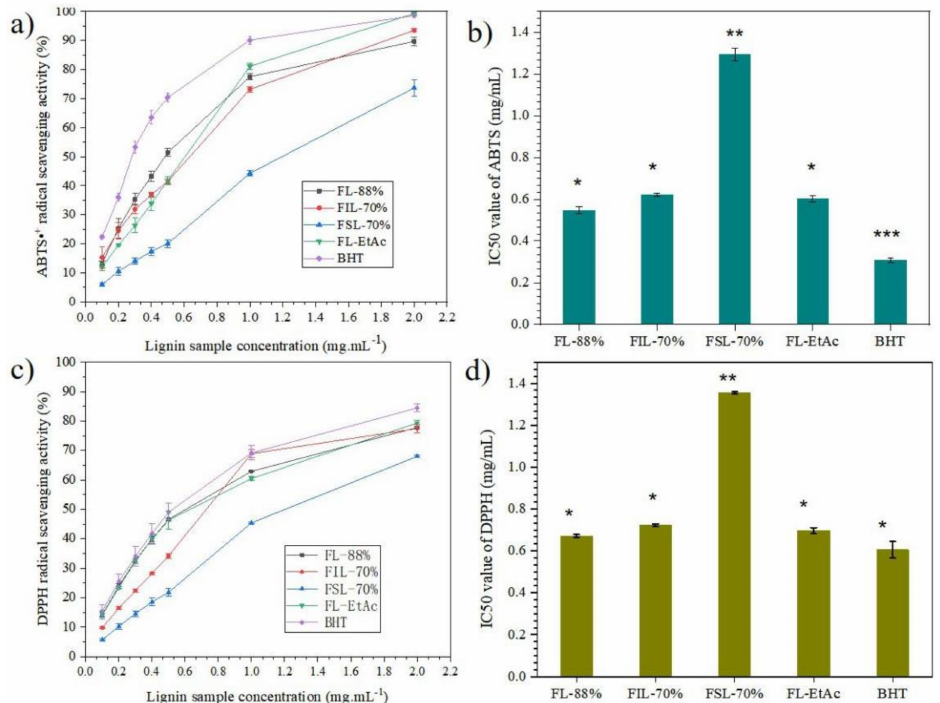
Figure 8. Antioxidant capacities of ABTS and DPPH radical scavenging activity for isolated lignin fractions. ( a ) ABTS radical scavenging activity; ( b ) IC 50 of ABTS analysis; ( c ) DPPH radical scavenging activity; ( d ) IC 50 of DPPH analysis. BHT was used as the positive control. Different asterisks represent significant differences ( p <